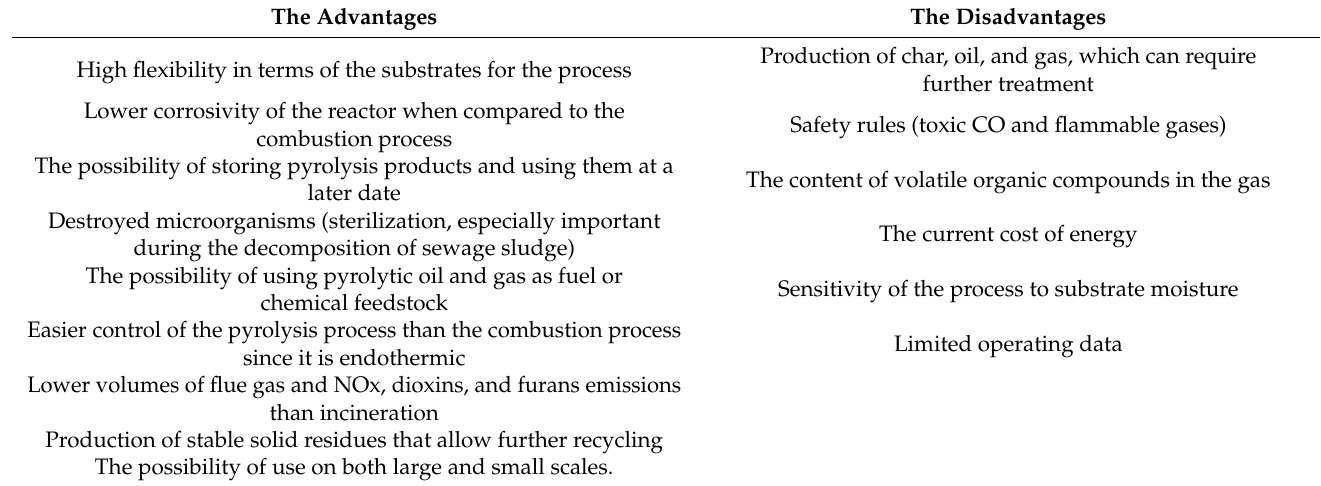
Table 1. General advantages and disadvantages of pyrolysis process